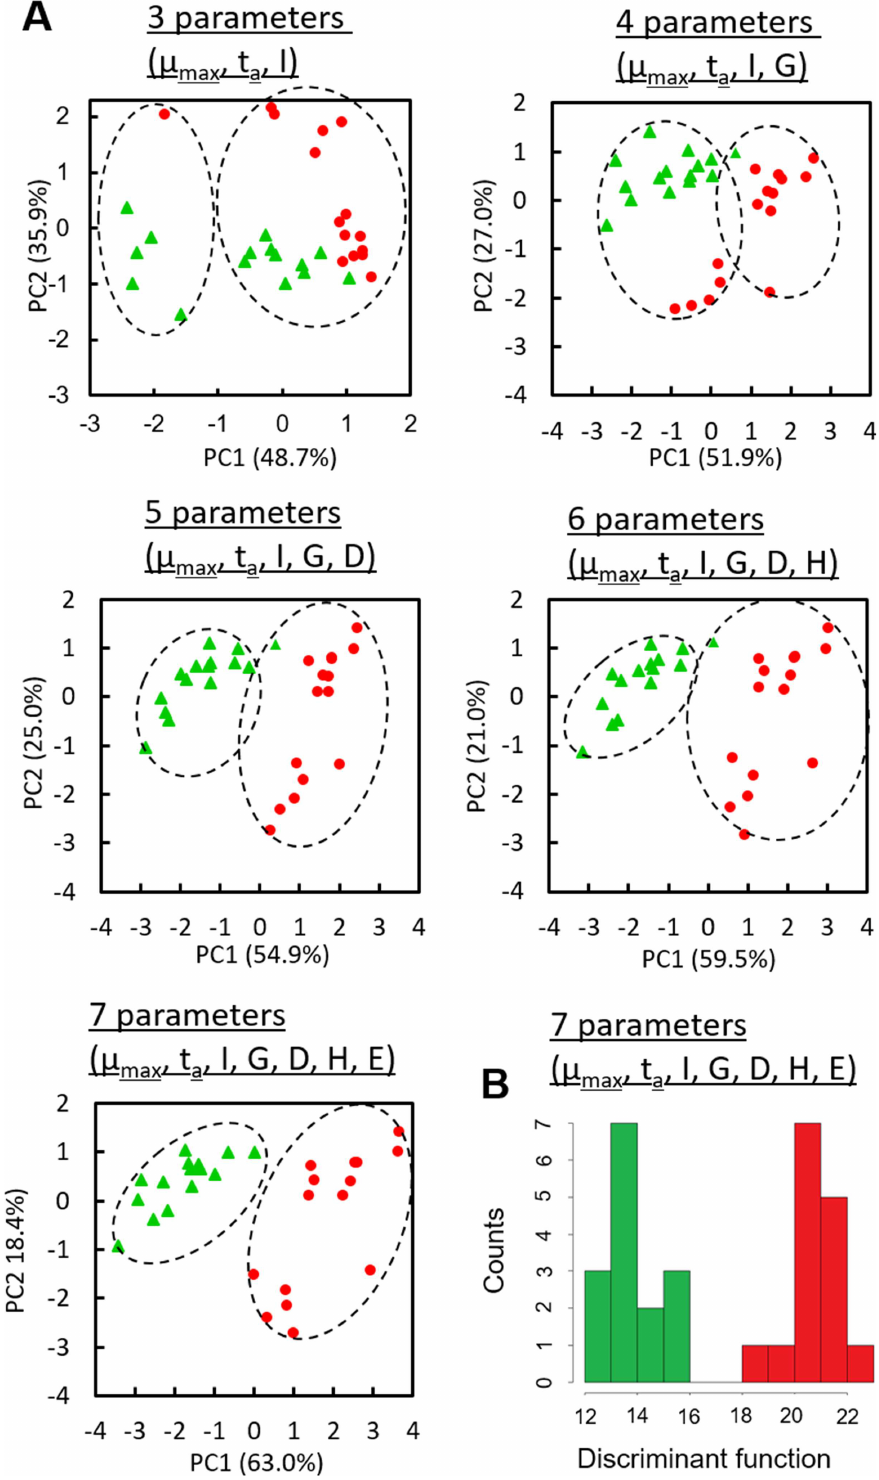
Fig 4. Discrimination results on St . aureus and St . epidermidis based on lensless images. Data points of 15 coloniesof the each microbialspecies were obtainedfrom two independentculture experiments using different set of the LB-agerchamberand CMOS sensor. Contributionratios (%) of PC1 and PC2 are shown, respectively. (A) Principalcomponentanalysis(PCA) of maximum specific growth rate ( μ max ), colony